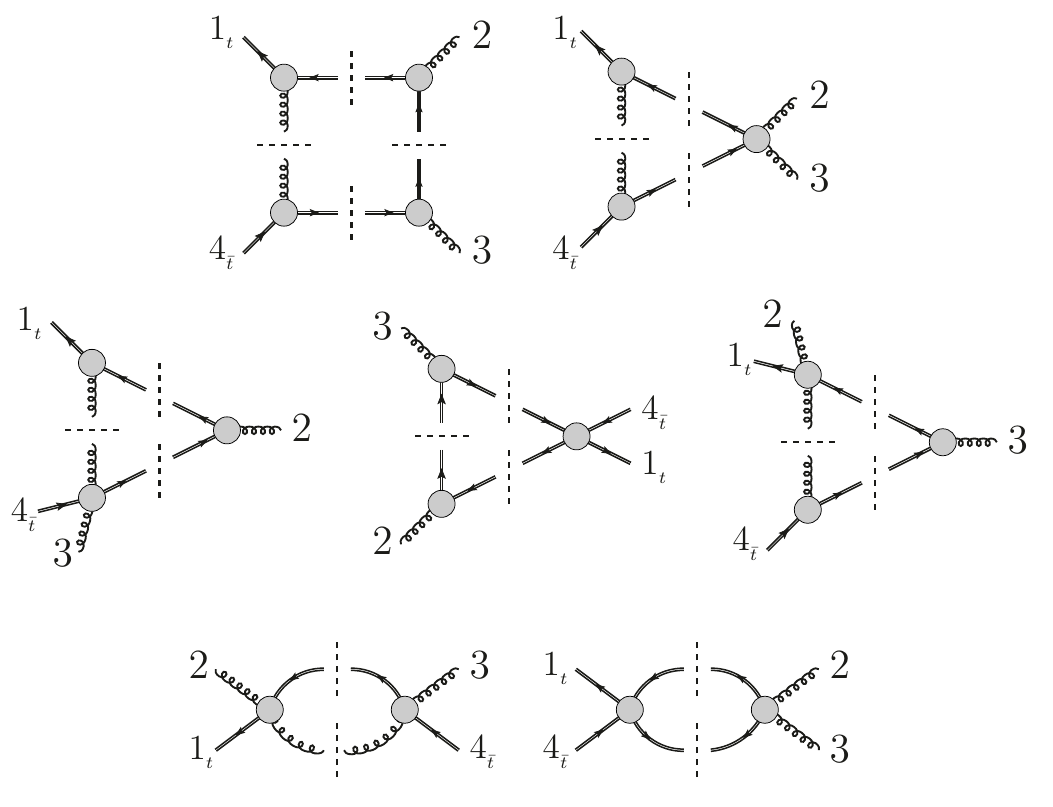
. Double lines represent massive t ; 2 ; 3 ; 4 (cid:22) t )